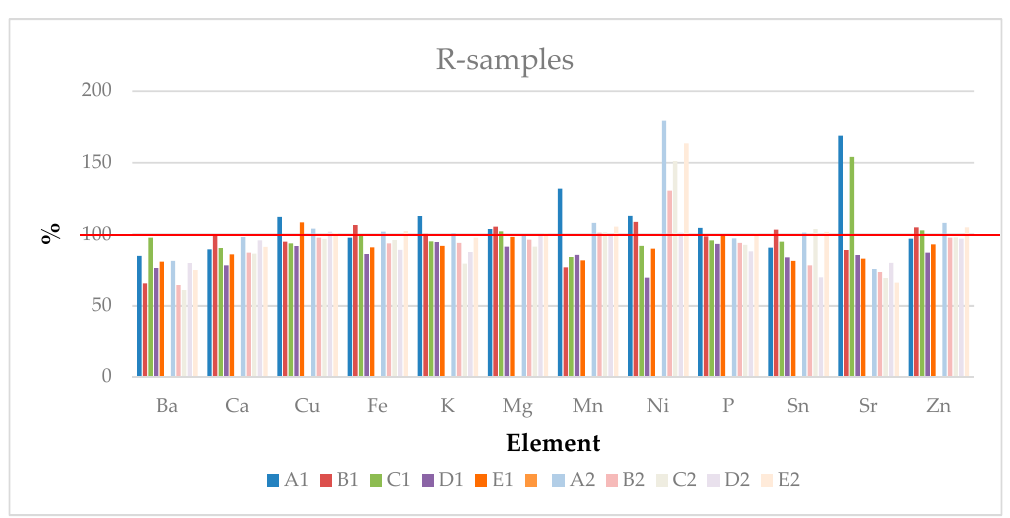
Figure 2. Concentration (%) of each element in the R-samples after four months of storage following the different methods (A–E), expressed with respect to T0 (100%).